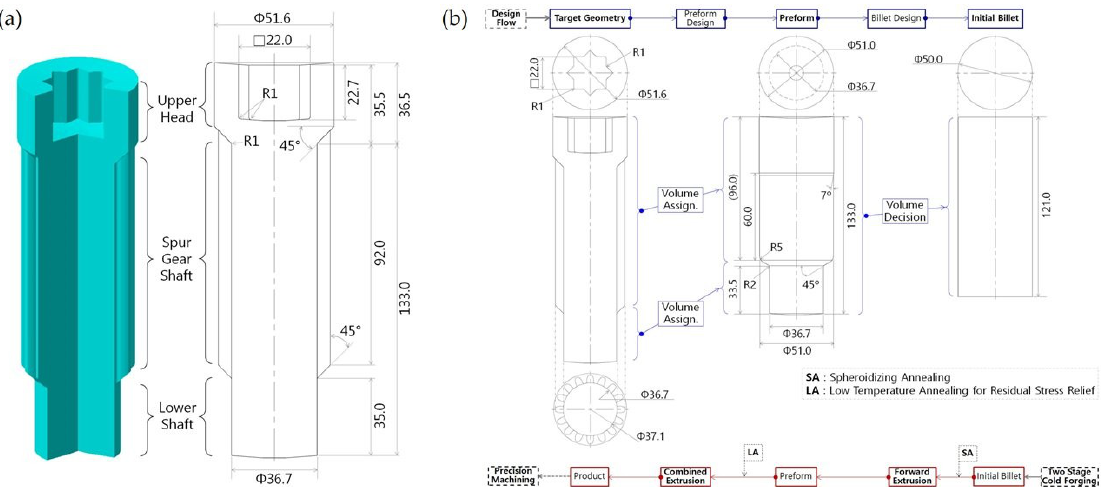
Figure 1. Schematic illustrations of drive shaft with internal spline and spur gear geometries (unit: mm): ( a ) Three-dimensional configuration and detail dimensions; ( b ) Process design flow and operation procedures of two-stage cold forging.